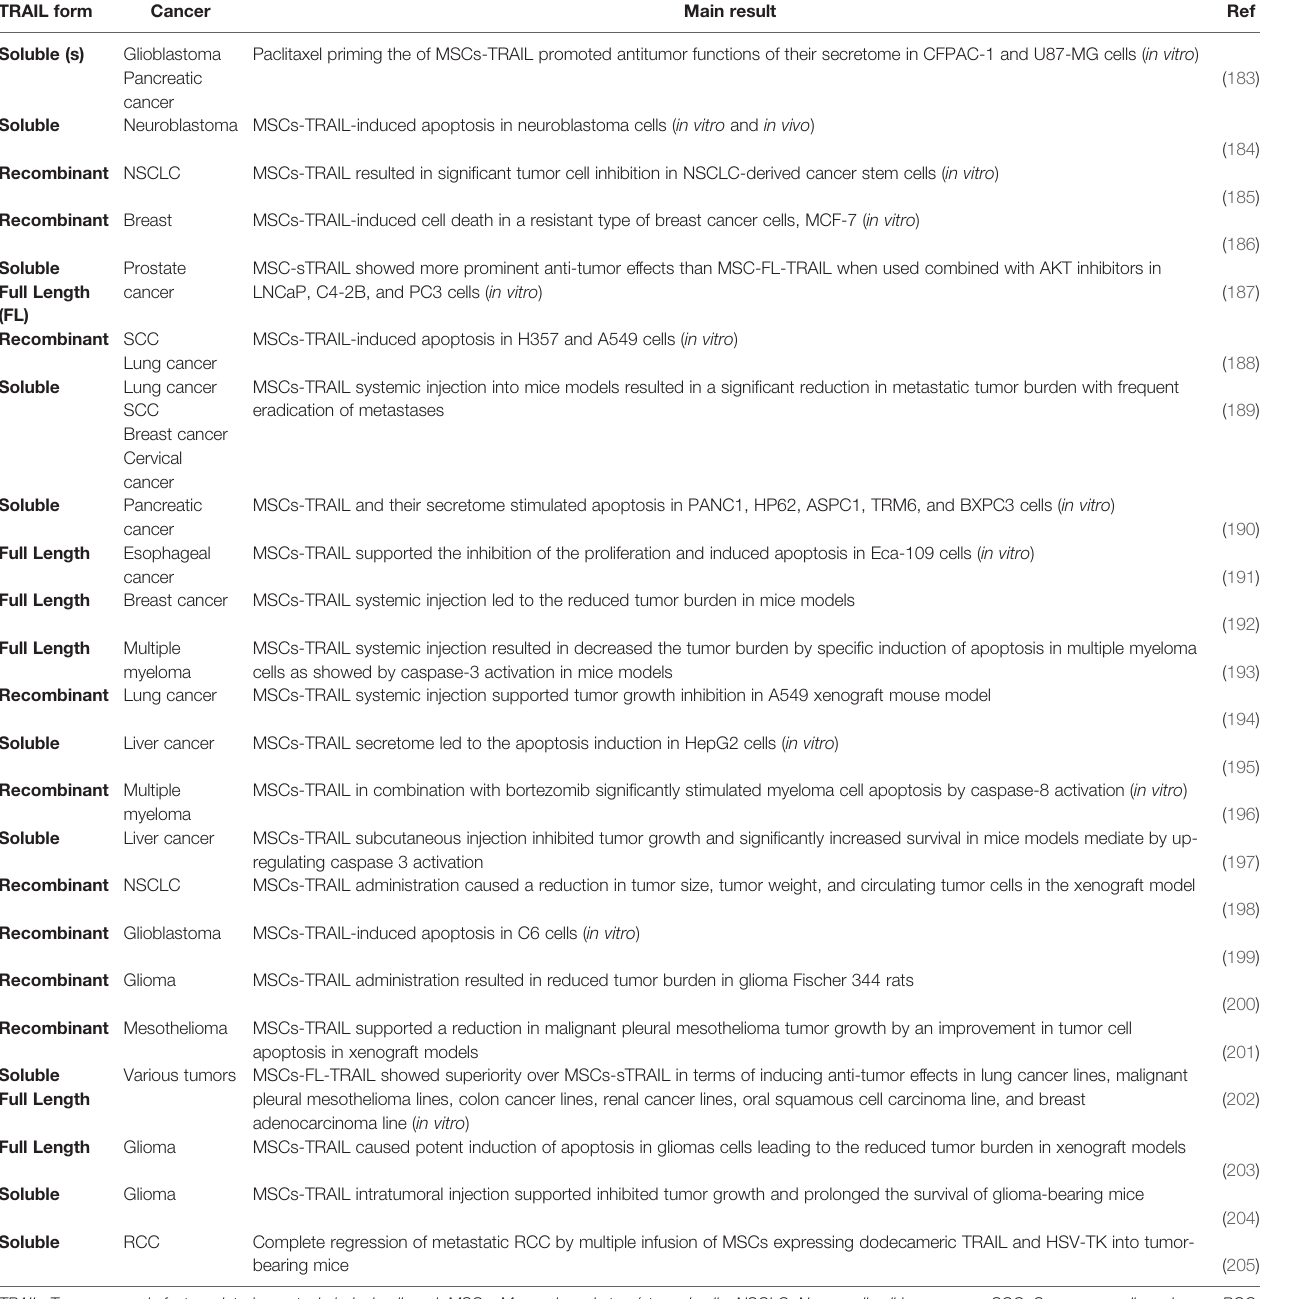
TABLE 3 | MSCs-based delivery of TRAIL in human tumor cells. TRAIL